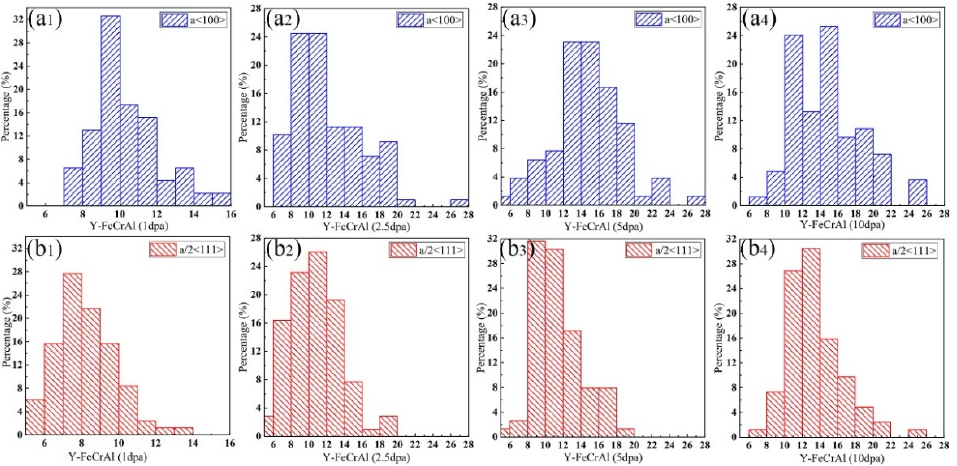
Figure 6. Size distribution of ( a 1 – a 4 ) a<100> dislocation loops, and ( b 1 – b 4 ) a/2<111> dislocation loops in Y − FeCrAl alloy after irradiation to 1.0 dpa, 2.5 dpa, 5.0 dpa and 10.0 dpa.